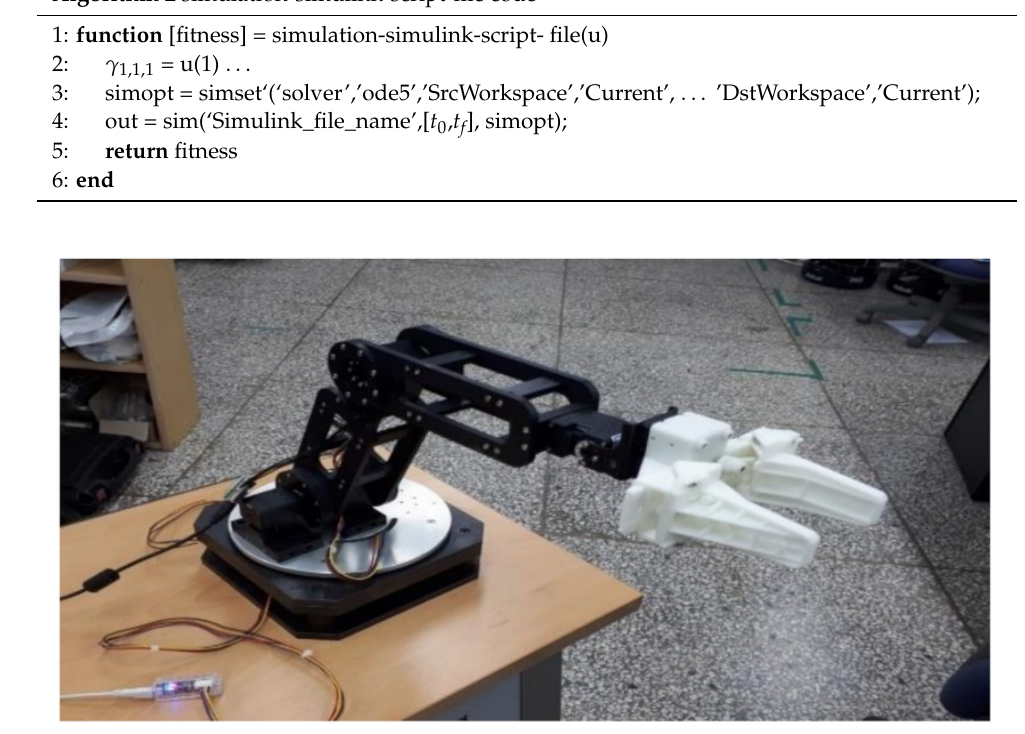
Figure 3. The configuration of the self-designed articulated manipulator system.